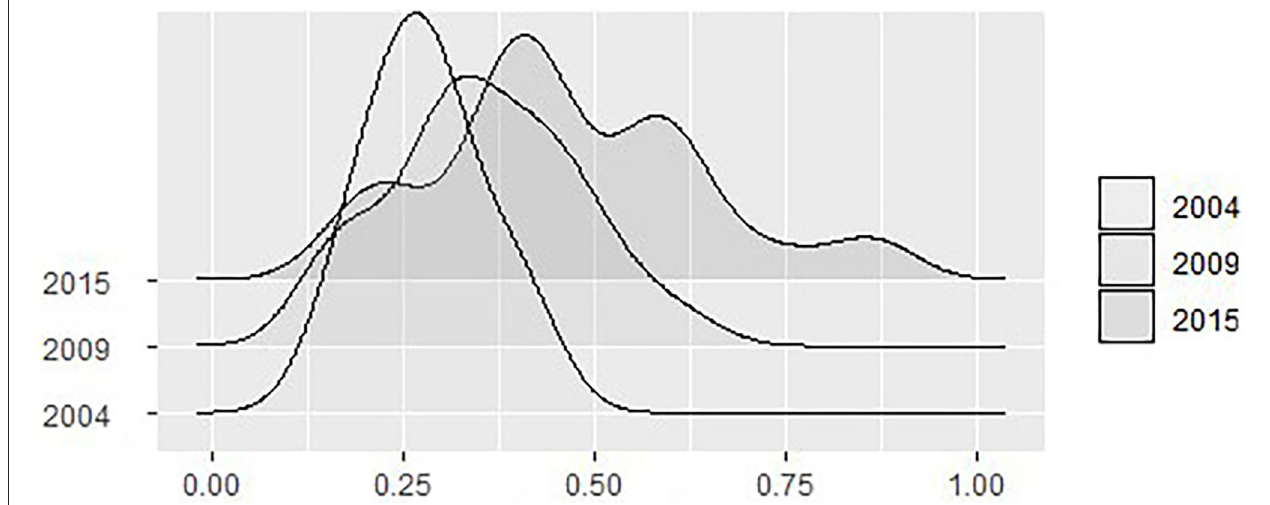
FIGURE 1 | The trend in national coupling coordination